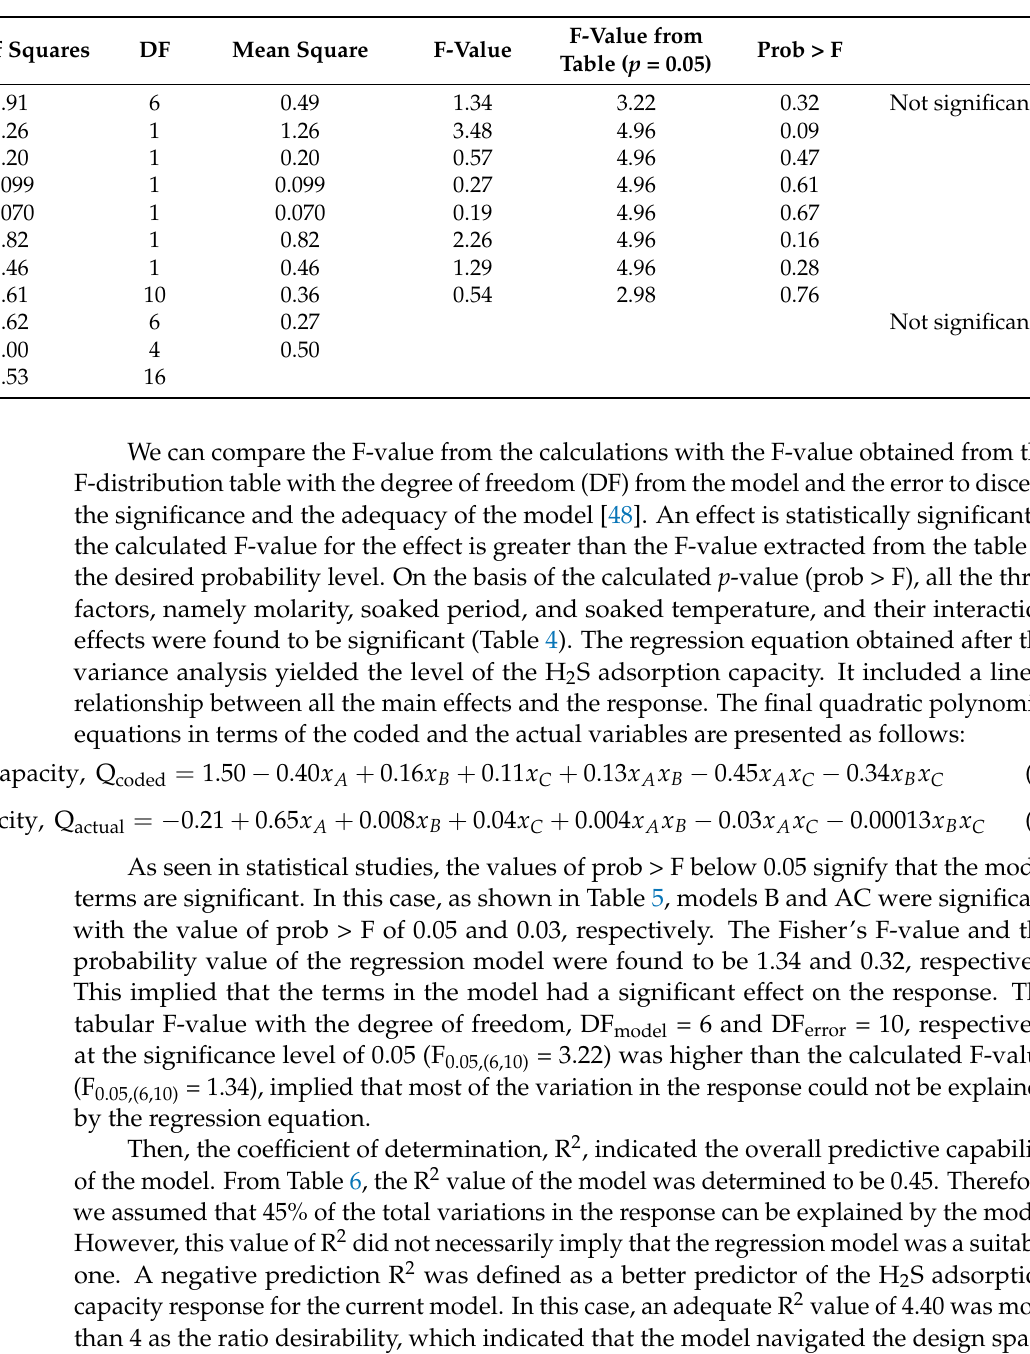
Table 5. Analysis of variance (ANOVA) of adsorption capacity